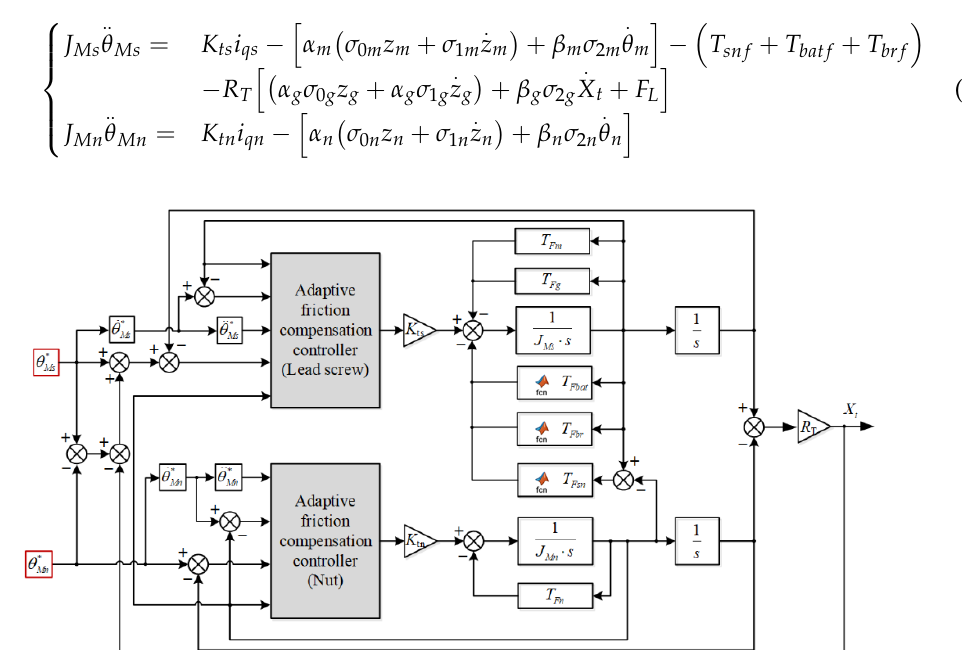
Figure 9. Block diagram of the AACA controller.